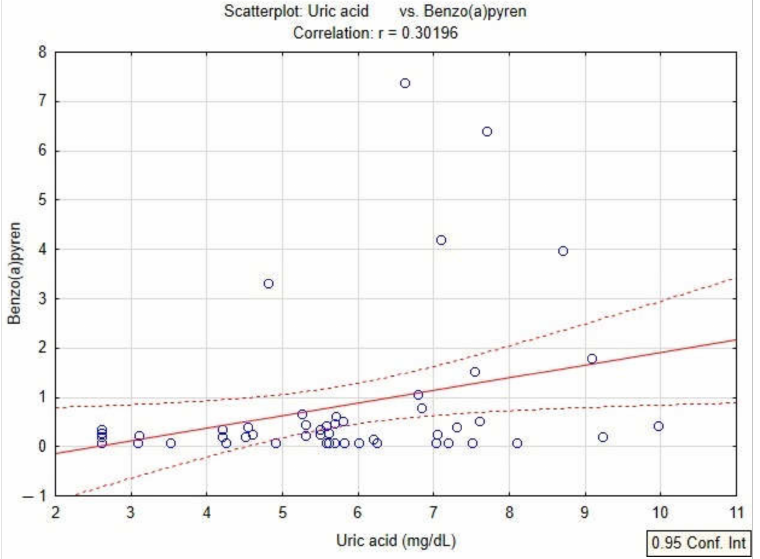
Figure 4. Linear regression between serum uric acid and levels of BaPy in patients with